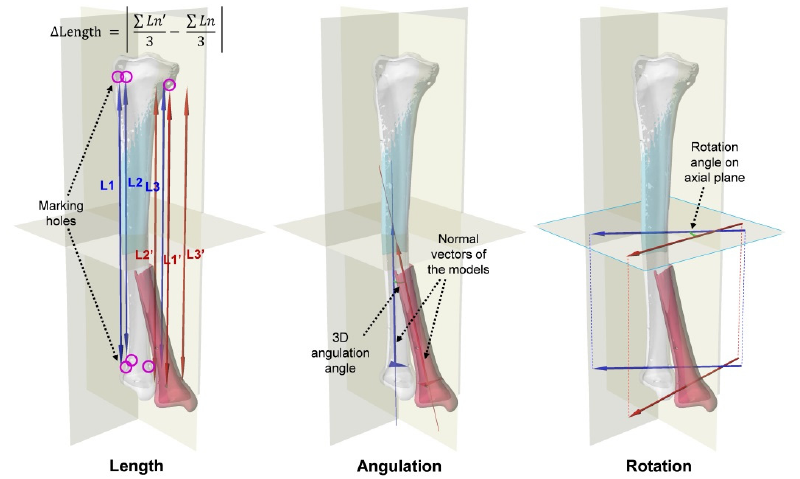
Figure 3. Evaluation of the alignment with the proximal fragment of the models overlapped: length (the mean distance between marking holes in longitudinal axis), angulation (3D angle between normal vectors of the distal fragments), and rotation (the angle between the axial plane projections of the vectors passing through two of the three distal marking